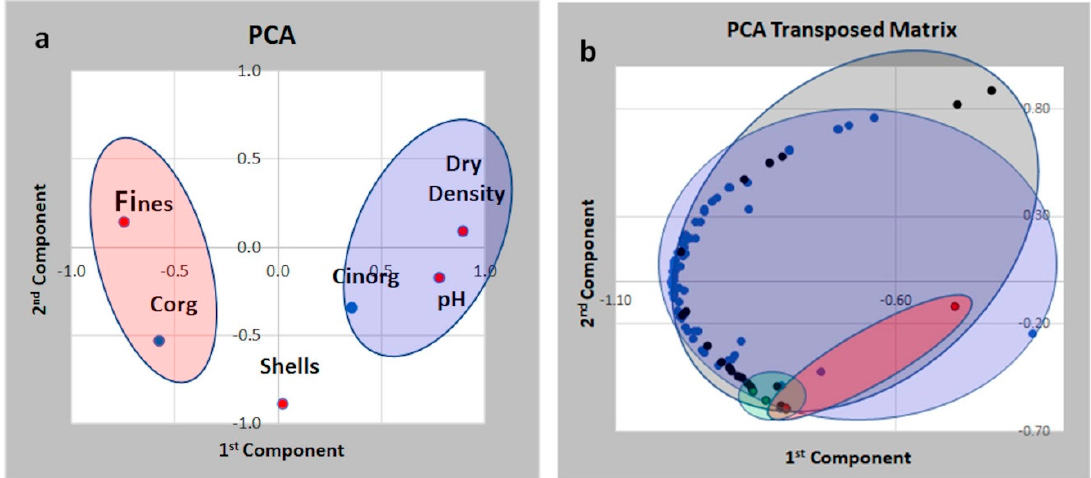
Figure 6. ( a ) Principal component analysis (PCA) among carbon species and surface sediment characteristics. Red small circles represent values of loading > 0.7. Large circles show the different parameters clustering associated to bad (red) or good (blue) ecological conditions. ( b ) PCA of the transposed matrix to highlight the station associations. The different colors show different TWSs. In blue: Venice Lagoon; in black: lagoons and ponds of the Po Delta; in green: Pialassa della Baiona; in red: Comacchio Valleys.